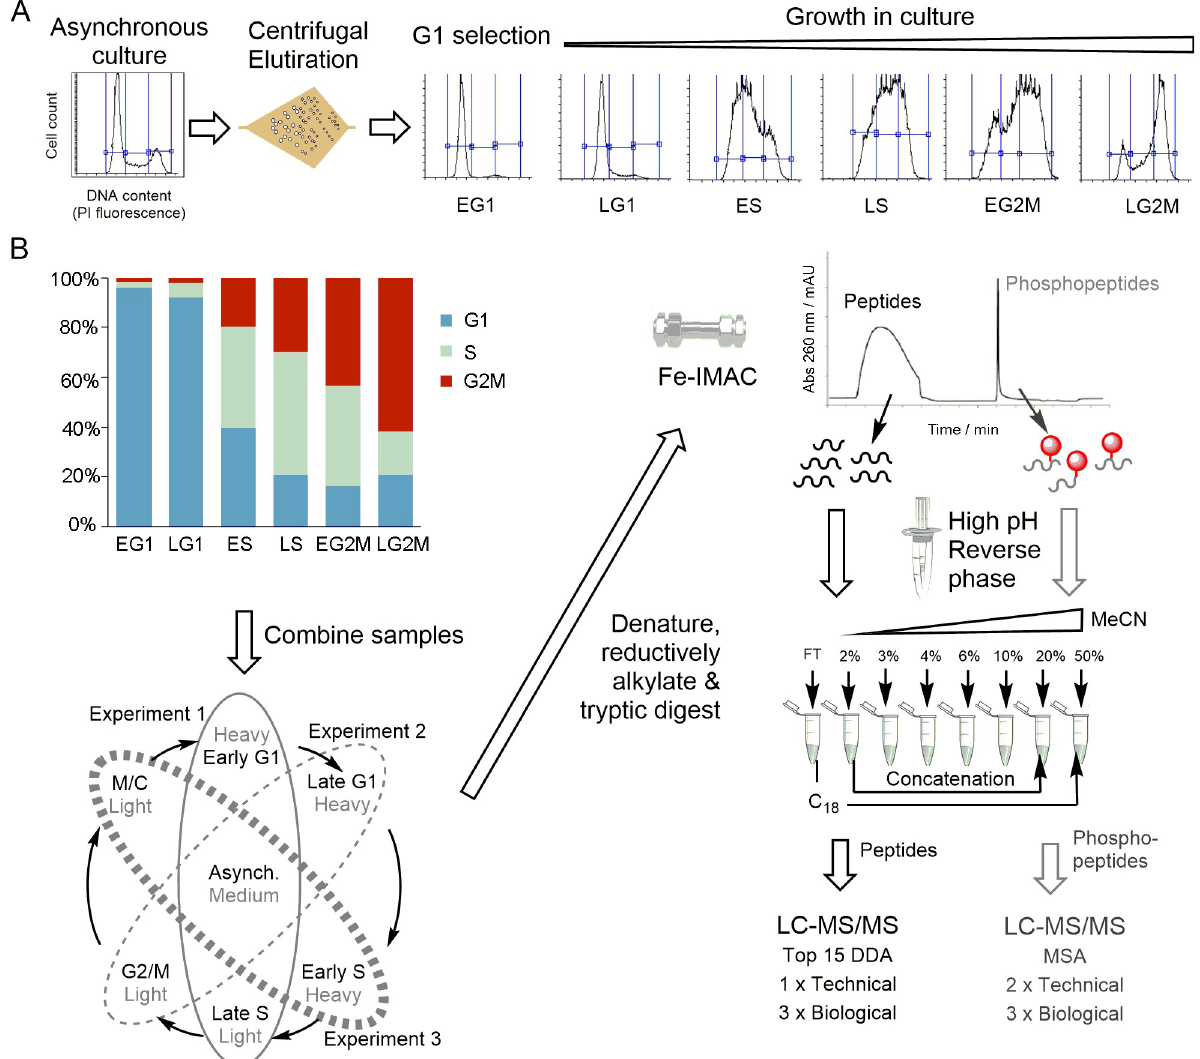
Fig 1. Schematic overview of the experimental workflow. A. An early G1 population was selected from an asynchronous culture of SILAC labelled cells using counter-flow centrifugal elutriation [19] and cultured prior to harvest at various time points, with position in the cell cycle recorded by flow cytometry of DNA content. B. Samples were grouped into recognisable cell cycle time points, and differentially labelled time points were combined with a medium-labelled asynchronous control. The combined sample was processed to tryptic peptides and subjected to Fe-IMAC to separate the peptides from phosphopeptides, which were then processed in parallel. High pH reverse phase separation was used to fractionate the sample, and concatenated to 5 fractions prior to LC-MS/MS analysis. DDA–Data dependent acquisition; MSA–Multi-stage activation.